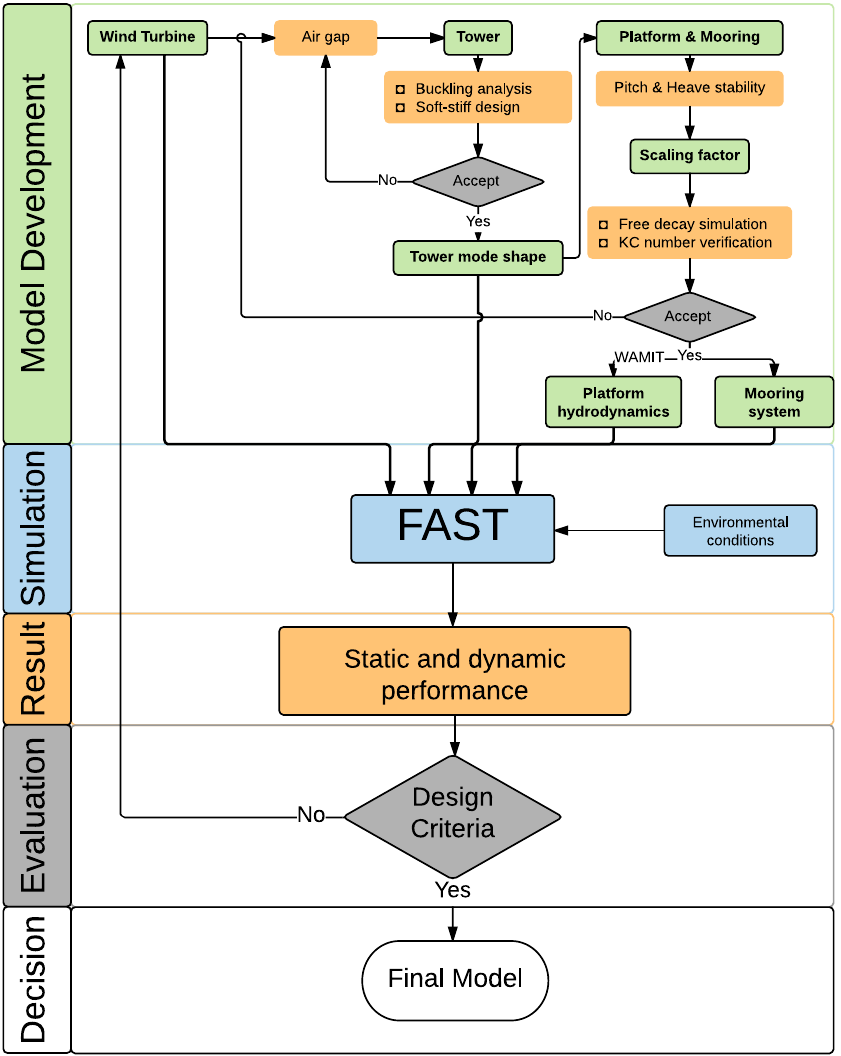
Figure 5. Iterations in the model